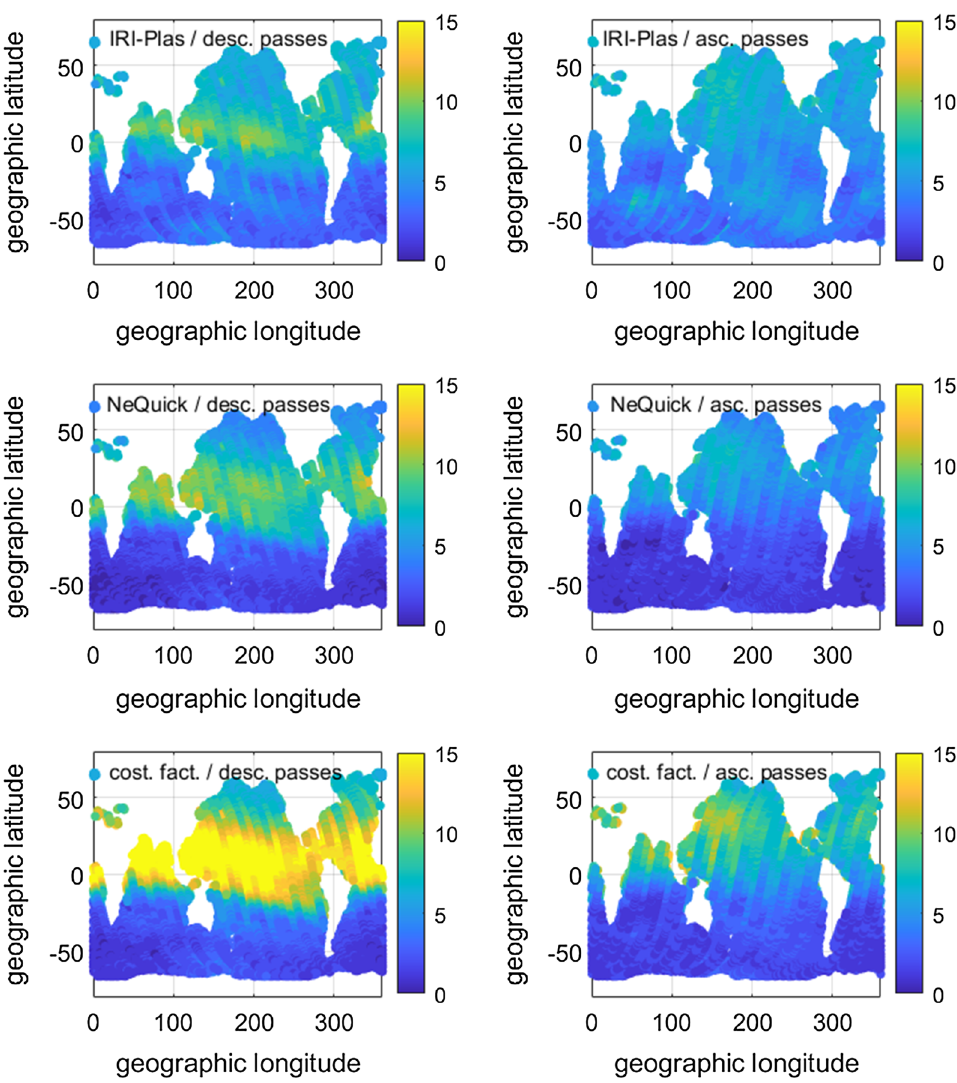
Fig. 2 Plasmaspheric part of scaled ionospheric correction for Jason-1 Cycle 015 for three different scaling approaches (top: IRI-Plas ratio; middle: NeQuick ratio; bottom: constant factor) and separately for descending passes (left-hand side) and ascending passes (right-hand side). Colours indicate differences between scaled range delays and unscaled range delays in